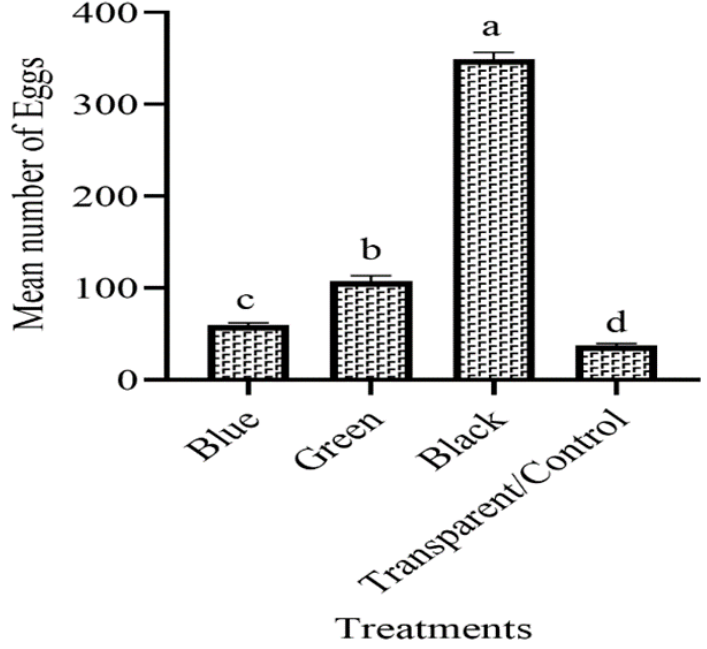
Figure 1. The mean number of eggs of Aedes aegypti to various color ovitraps in the laboratory. These letter shows significant difference among treatments.